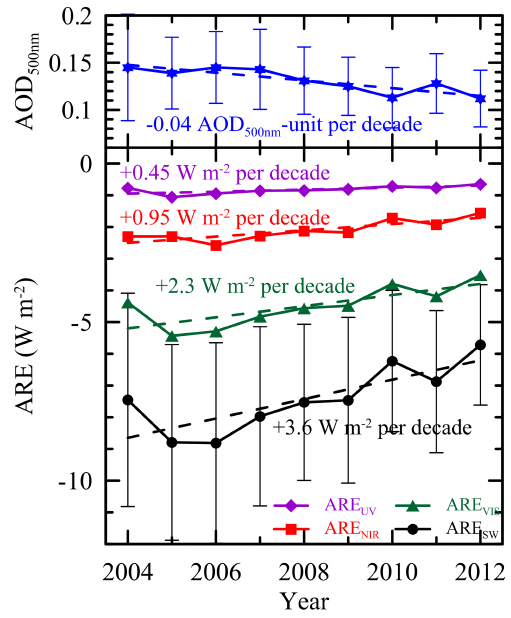
Figure 6. Evolution of annual ARE at the four spectral ranges (ARE UV purple diamonds, ARE VIS red squares, ARE NIR green tri- angles, and ARE SW black circles) and AOD at 500nm (blue stars), averaging the data from the six Iberian ground-based sites (only years with at least three sites considered). Dashed lines point out the linear trends (see text).